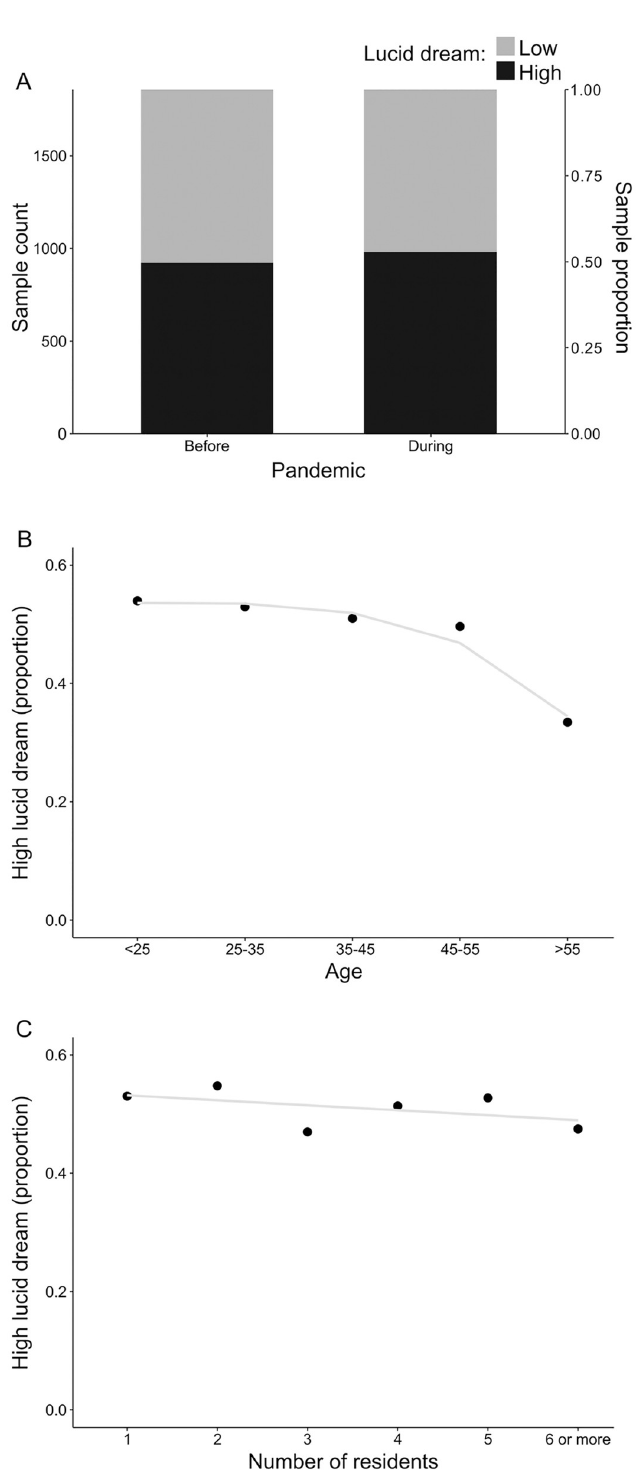
Fig 2. Representation of main effects unveiled by the mixed logistic statistical model. (A) The proportion of high lucid dreamers before and after the pandemic. (B) The proportion of respondents declaring high frequency of lucid dreams according to the corresponding category for age. Because these categories are somewhat arbitrary, a rough smoothing for the relation between the variables (blue line) was added to the plot to improve interpretation. (C) The proportion of high lucid dreamers conditioned to the number of residents sharing the house. In the absence of any clearer representation, the relationship between these variables is summarized by a straight (blue) line to enhance visual